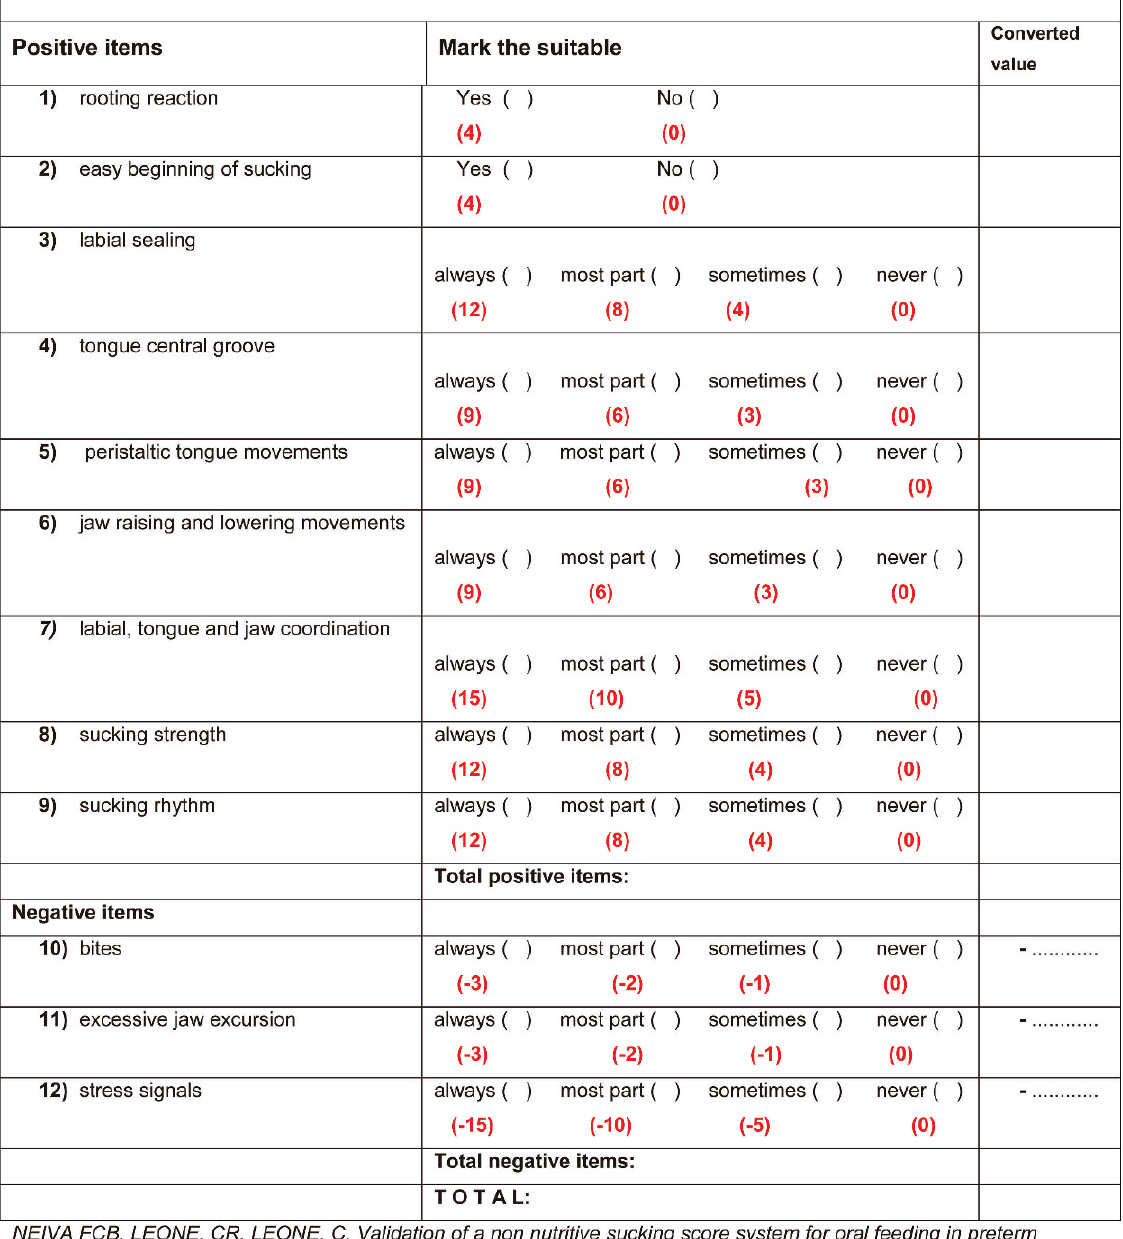
Figure 1 - Non-nutritive sucking score